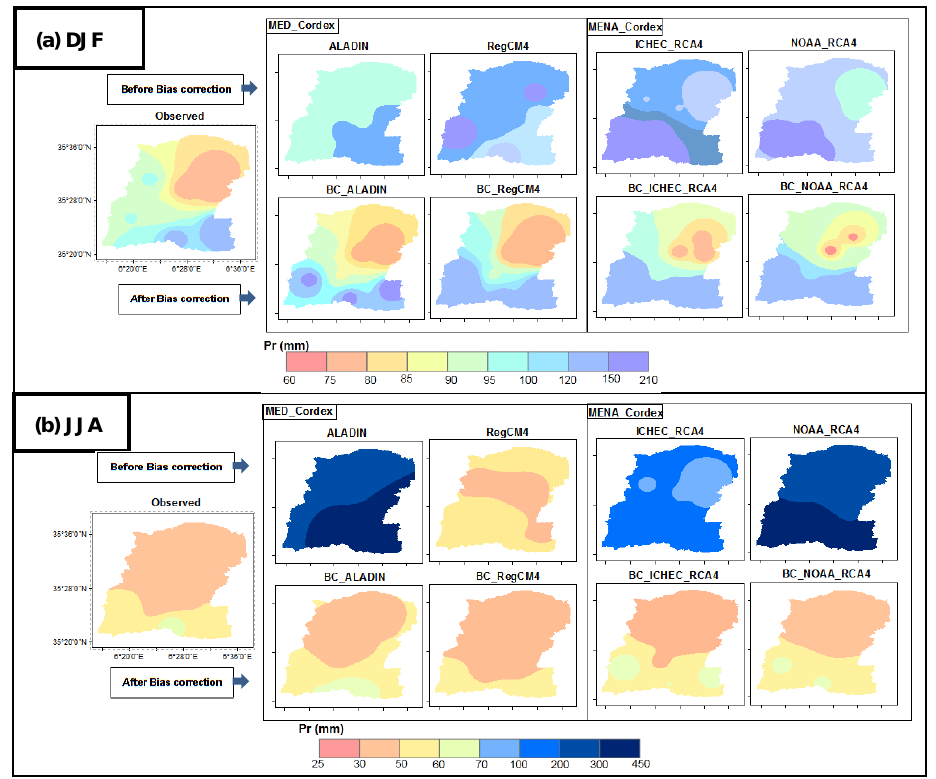
Figure 8. The spatial distribution of averaged seasonal precipitation for observed, raw, and adjusted (BC) RCMs for the period (1970 – 2005) in the study area ( a ) for winter (DJF) and ( b ) for summer (JJA).